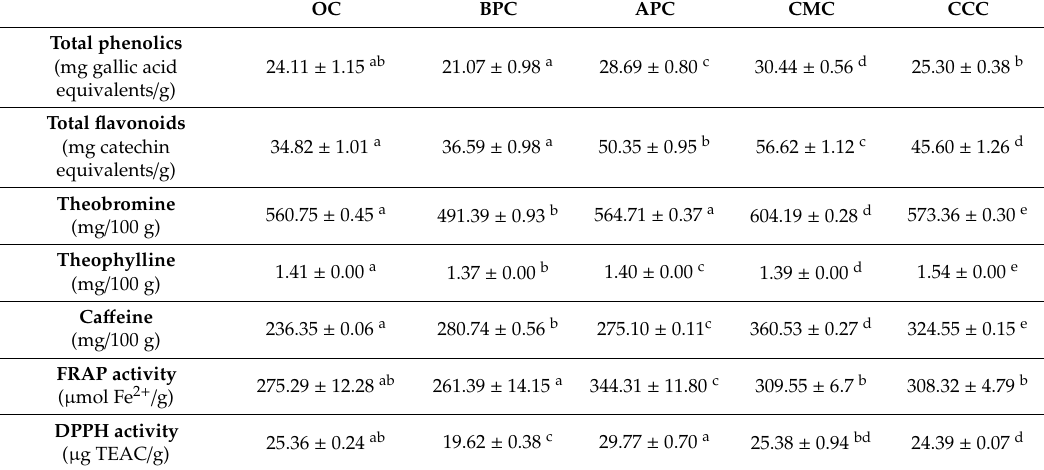
Table 1. Content of total polyphenols and flavonoids, methylxanthines and antioxidant capacity in the cocoa populations considered in the study. APC: “Amazonas Peru” cocoa; BPC: “Blanco de Piura” cocoa; CCC: “Chuncho” cocoa; CMC: “Criollo de Montaña” cocoa; OC: ordinary cocoa. Results are represented as mean ± standard error of the mean from three independent experiments. Values not sharing letters denote significant di ff erences between populations ( p < 0.01) while values sharing the same letter did not di ff er. OC BPC APC CMC